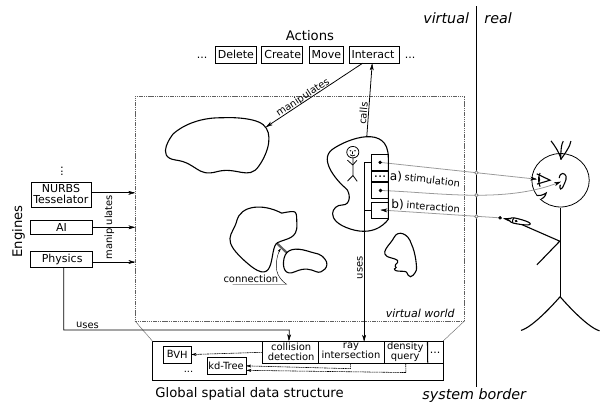
Fig. 3. Illustration of the coupling of the real and virtual world. The attendee is the central connection. It is responsible for the sensual stimulation of the user and the processing of user interaction. The blobs inside the virtual world represent scene